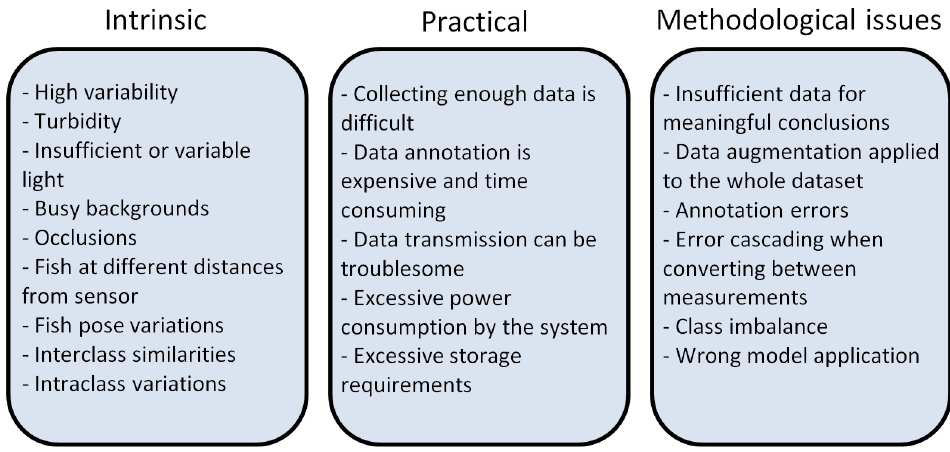
Figure 2. Synthesis of the main challenges and issues identified in this